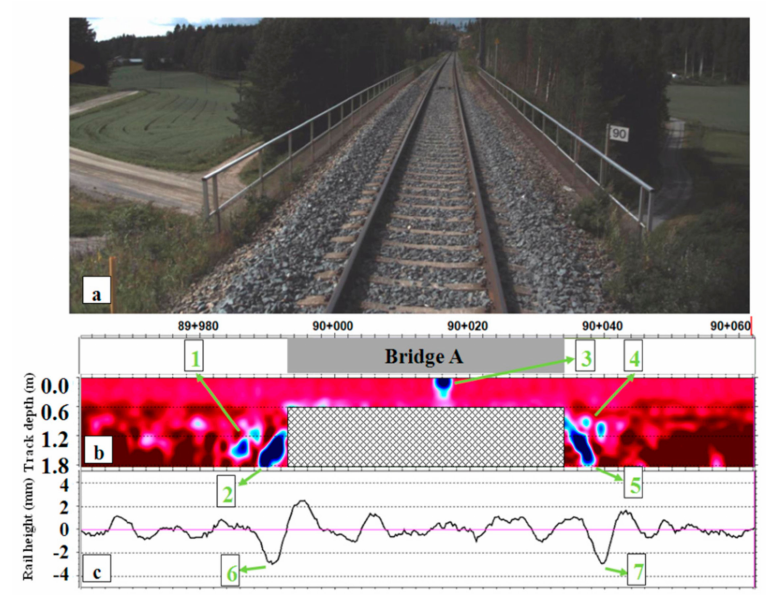
Figure 7. Measurement results of Transition Zone A: ( a ) photograph of the track; ( b ) the moisture profile; and, ( c ) the longitudinal track level.